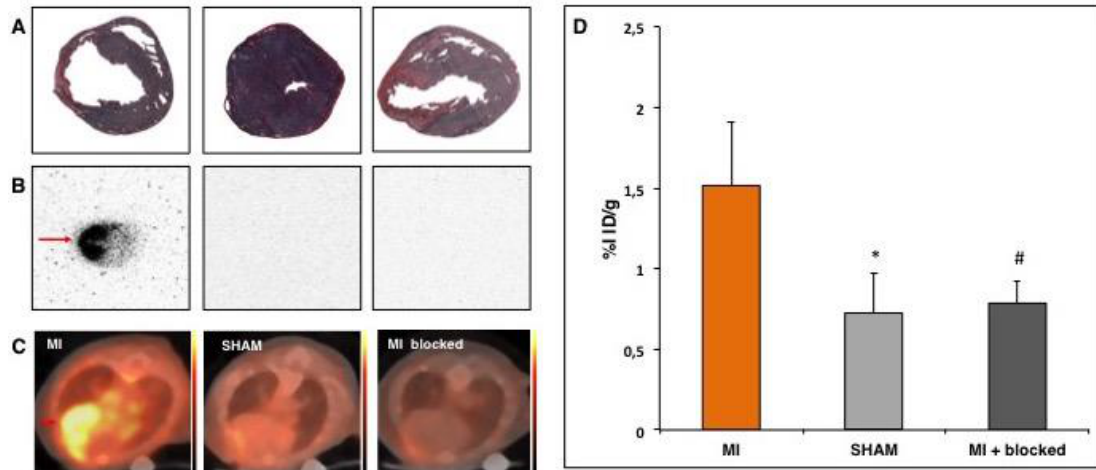
Figure 3. [ 68 Ga]-NODAGA-RGD positron emission tomography (PET) seven days after surgical induction of myocardial infarction shows enhanced focal tracer accumulation within the granulation tissue of the infarct scar. ( A , B ) Autoradiograms and Sirius Red stainings of adjacent myocardial cross sections. Highest tracer accumulation was detected in the scar area (red arrow), injection of cilengitide 10 minutes prior to tracer application reduced focal activity to SHAM level. ( C ) Axial PET / CT showing high focal uptake of [ 68 Ga]-NODAGA-RGD with in the scar, which is suppressed to SHAM level by cilengitide application. Color bars: 0 to 160 kBq / ml (MI) and 0 to 130 kBq (SHAM and myocardial infarction (MI) blocked). ( D ) %ID / g was measured by positioning a VOI of 20 µ L into the brightest area within the scar. * p < 0.005 vs. MI; # p < 0.05 vs. MI.